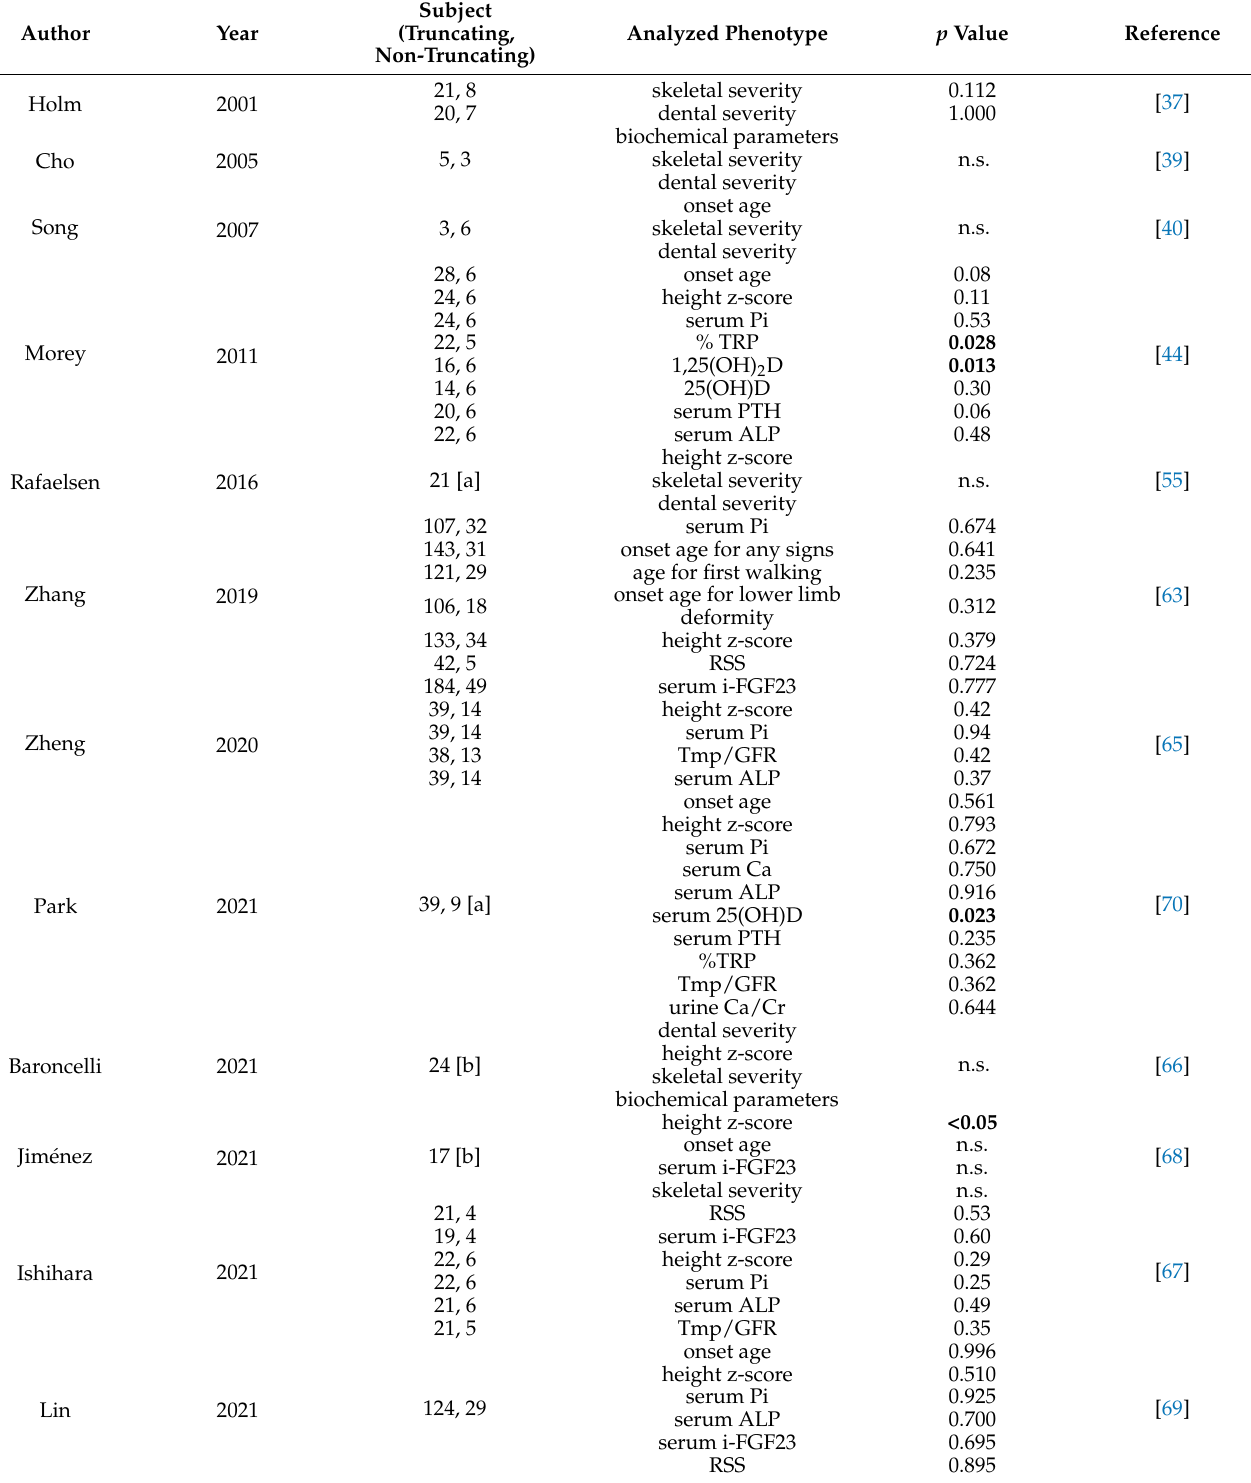
Table 4. Summary of analyses on PHEX